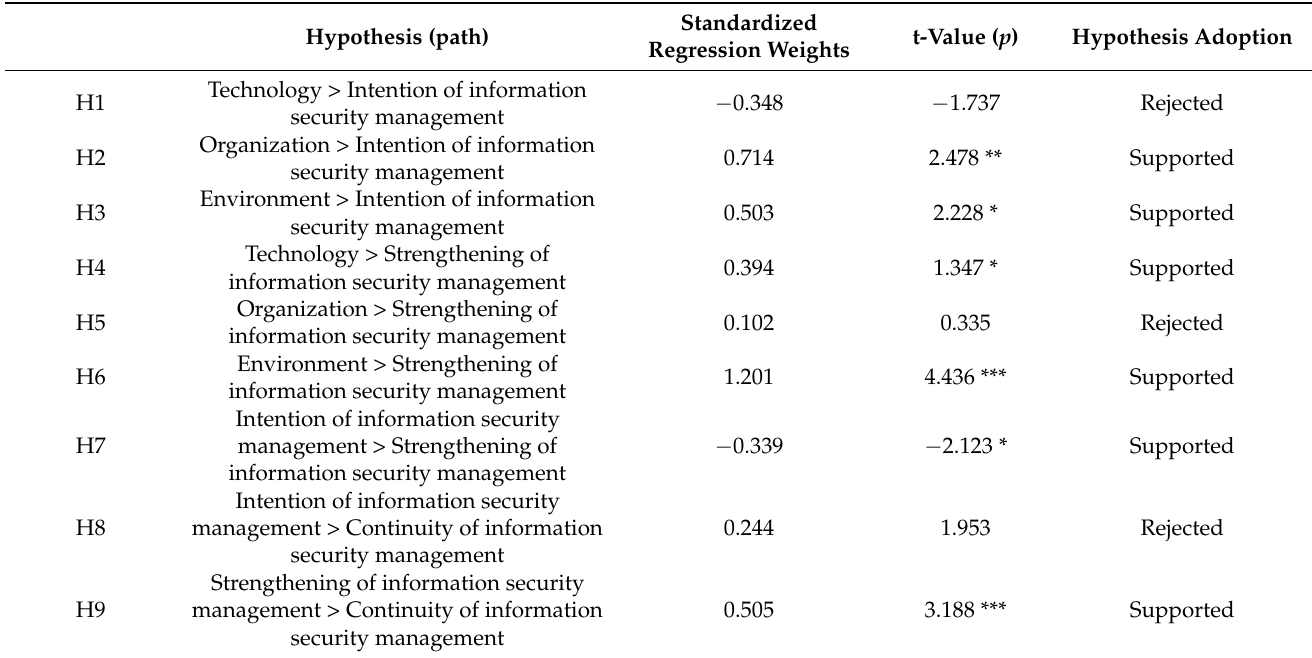
Table 5. Results of a hypothesis